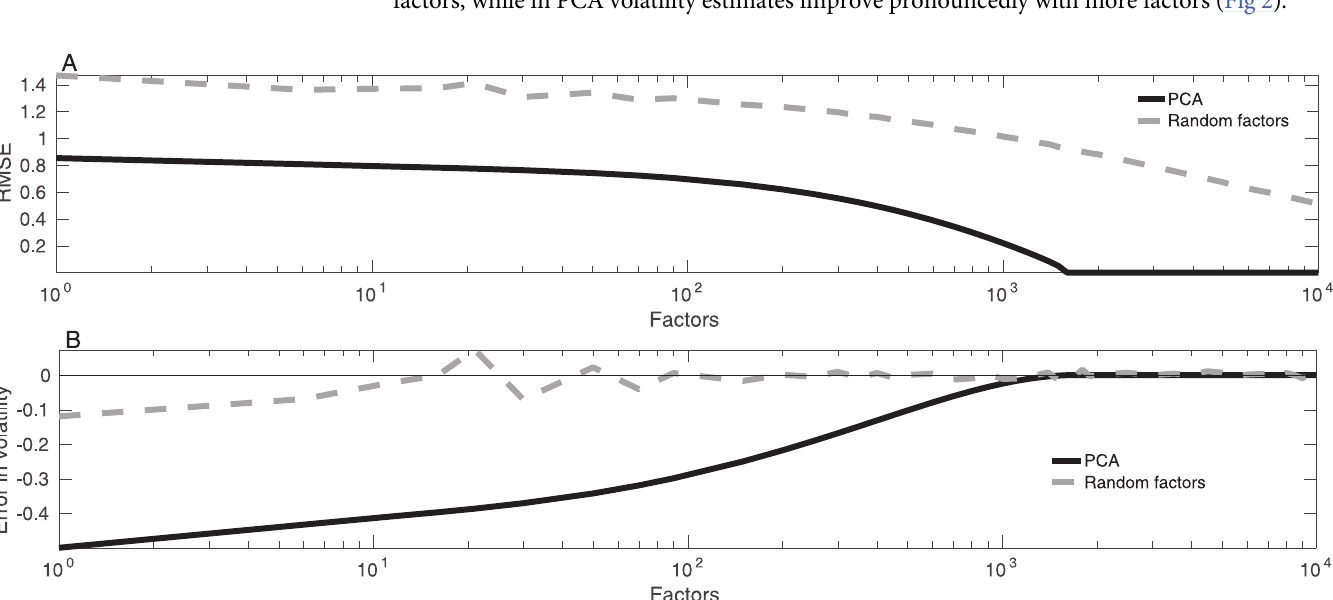
Fig 2. Accuracy of time-series representations. Error in time-series reproduction using the random factor model (dashed gray curve) and PCA (black solid curve) measured by RMSE (top panel), where curves are shown as functions of the number of factors. Error in reproduction of time-series volatility using the random factor model (dashed gray curve) and PCA (black solid curve) as a function of the number of factors (bottom panel). Errors are relative to the volatility of the time-series due to